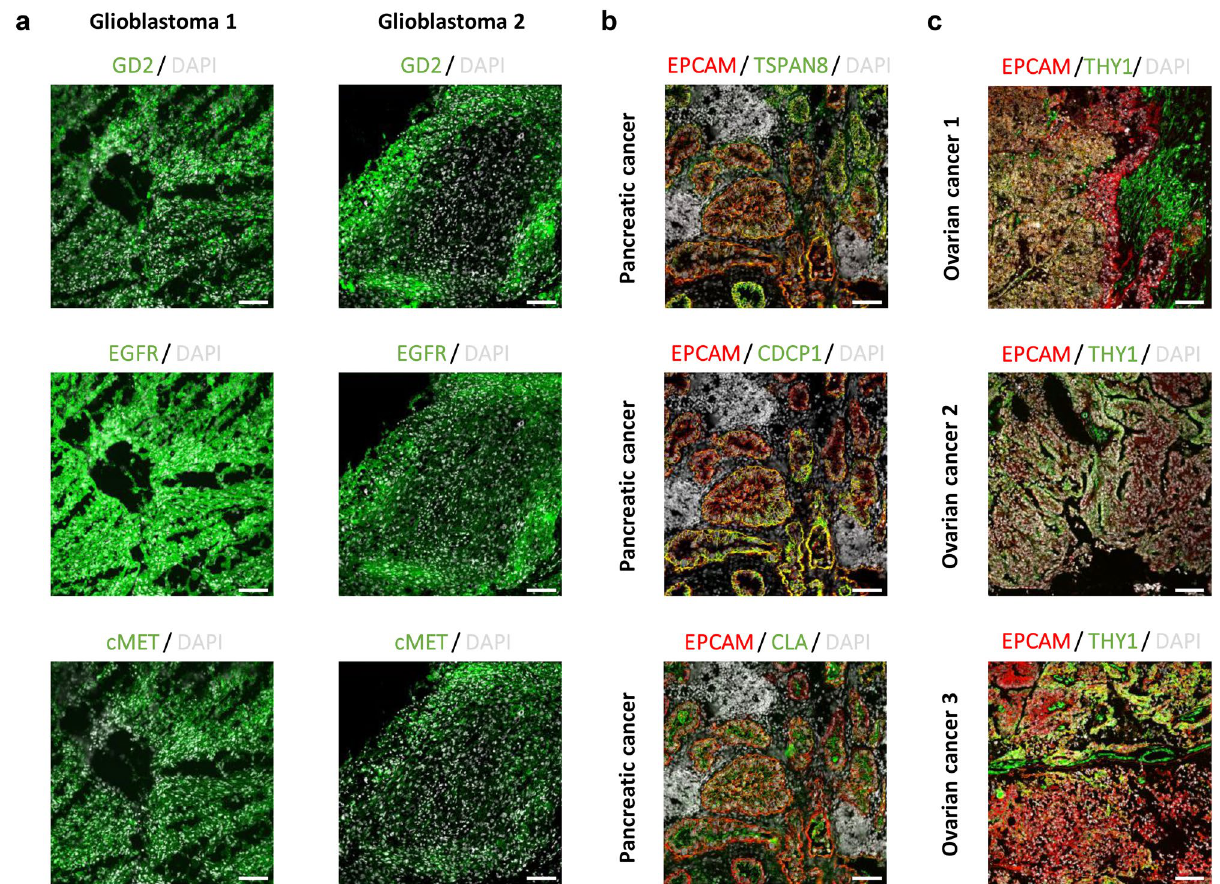
Figure 4. Ultrahigh-content imaging enables the discovery of novel targets and target pairs in different cancer indications which can be targeted and lysed in vitro by Adapter CAR T cells. ( a–c ) Fresh-frozen human GBM, PDAC, and HGSOC samples were sliced and analyzed by MICS. DAPI is shown in white and the indicated markers of interest are shown in green or red. Scale bar represents 100 µm. ( a ) Examples of MICS analysis of two GBM patient samples showing the expression of GD2, EGFR and cMET. ( b ) Example of a PDAC patient sample analysis displaying the co-expression of EPCAM (red) as a general epithelial and tumor cell marker with